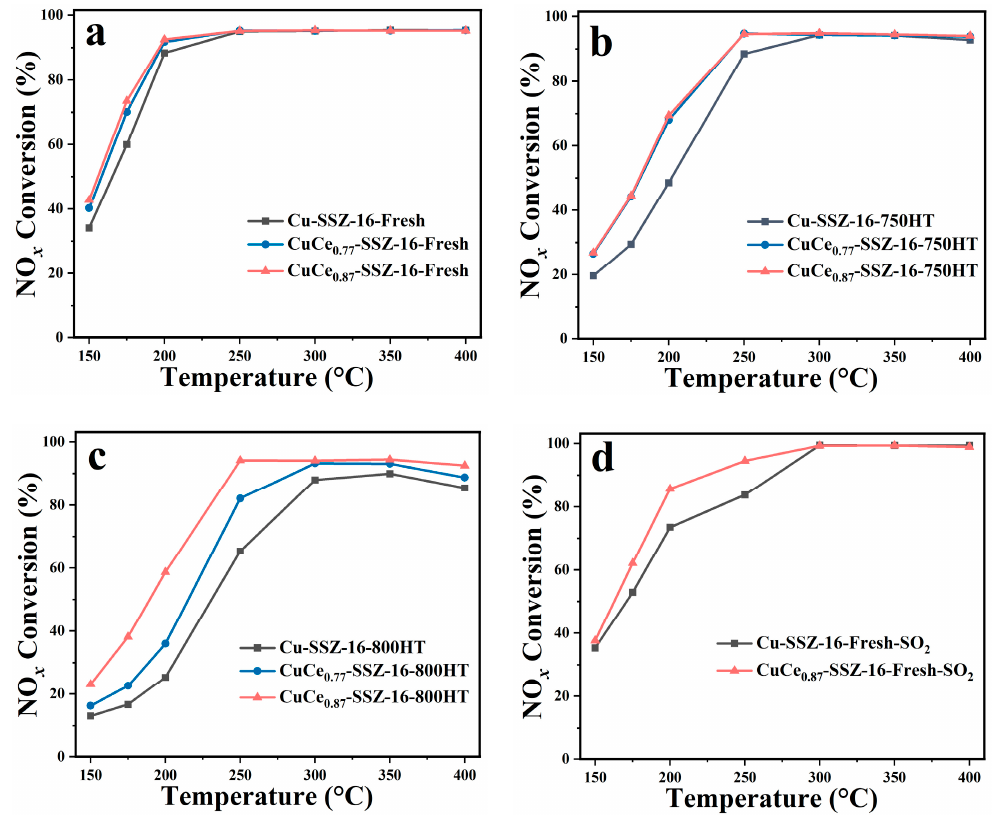
Figure 1. NO x conversion before ( a ), after hydrothermal treatments at 750 °C ( b ) and 800 °C ( c ), and in the presence of SO 2 ( d ) over Cu-SSZ-16, CuCe 0.77 -SSZ-16, and CuCe 0.87 -SSZ-16. Reaction conditions: 500 ppm NO, 500 ppm NH 3 , 50 ppm SO 2 (when used), 5 vol% O 2 , 5 vol% H 2 O, balance N 2 , and GHSV = 200,000 h − 1 .